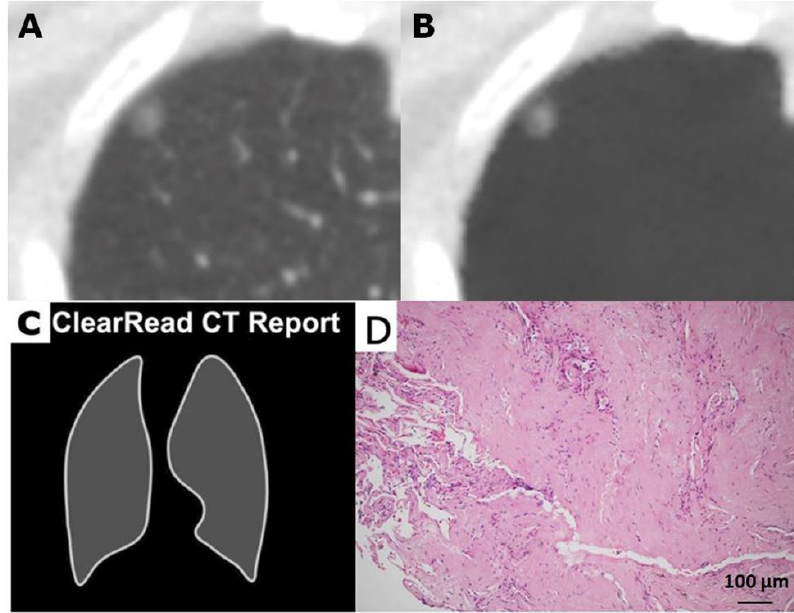
Figure 3. A 57-year-old female with a true negative cancer result ignored by the vessel-suppressed and computer-aided detection (VS-CAD) artificial intelligence (AI) for a small nodule in right upper lobe (RUL). ( A ) Low-dose computed tomogram and ( B ) the vessel-suppressed image revealed a 7 mm well defined and smooth-outlined ground-glass nodule in RUL. ( C ) The VS-CAD AI analyzer treated it as a non-actionable nodule and did not prompt an analysis summary. ( D ) The nodule was proved to be a benign lesion with inflammation, fibrosis and anthracosis by surgical pathology (hematoxylin and eosin stain, × 100).